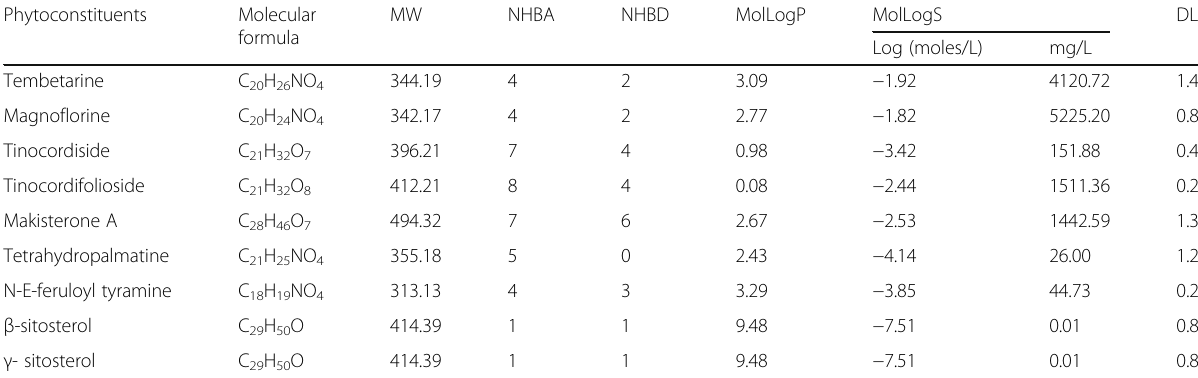
Table 2 Druglikeness property of phytoconstituents Phytoconstituents Molecular formula